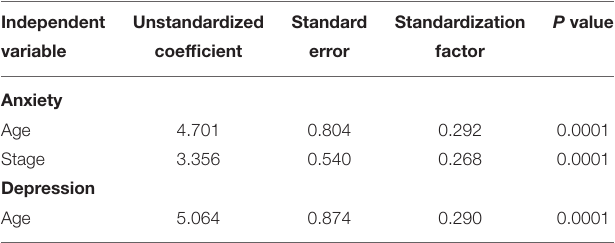
TABLE 3 | Multiple regression analysis of anxiety and depression in tumor radiotherapy patients.